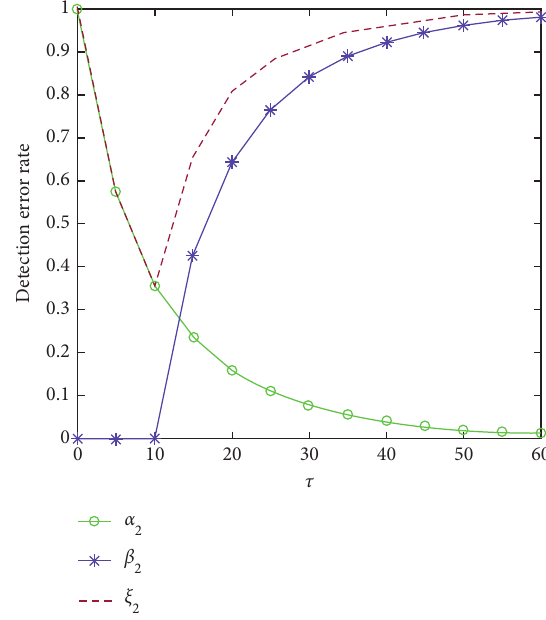
A with different | 2 � 1, ε � 0 . 05, j W Figure 8: Minimum detection error rate, false alarm rate, and missed detection rate versus τ , where σ 2 B � 0 dB , N R � 3, P max � P � 10 dB , and | h | 2 � 1. R k R k W R j